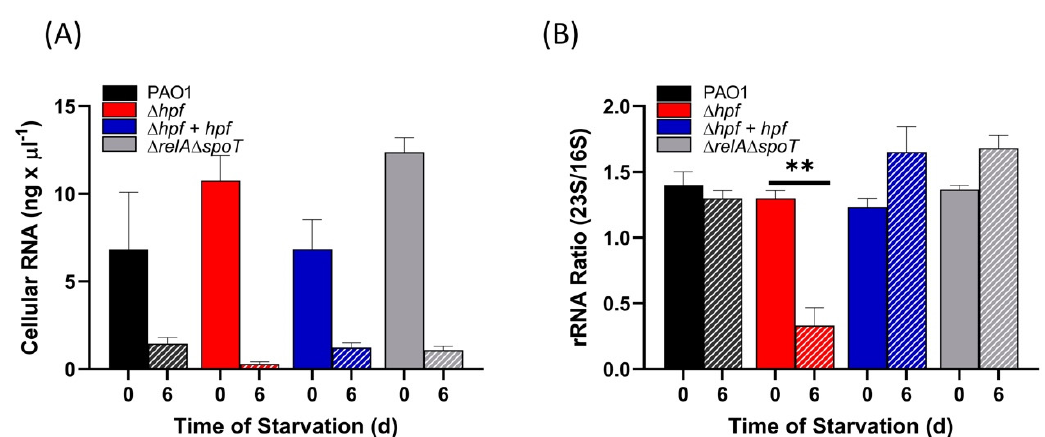
Figure 4. rRNA analysis of P. aeruginosa and mutant strains prior to starvation (solid bars) and after 6 d of starvation (striped bars). ( A ) Total RNA abundances of pre-starved and 6 d starved cells assayed using the NanoDrop Spectrophotometer. ( B ) 23S / 16S rRNA ratios of cells prior to starvation and following 6 d starvation, determined using the Agilent Bioanalyzer. Data show the mean and standard error of the mean for at least three independent replicates. Asterisks (**) for 23S / 16S ratio shows significant difference between 0 and 6 d ( p < 0.001).